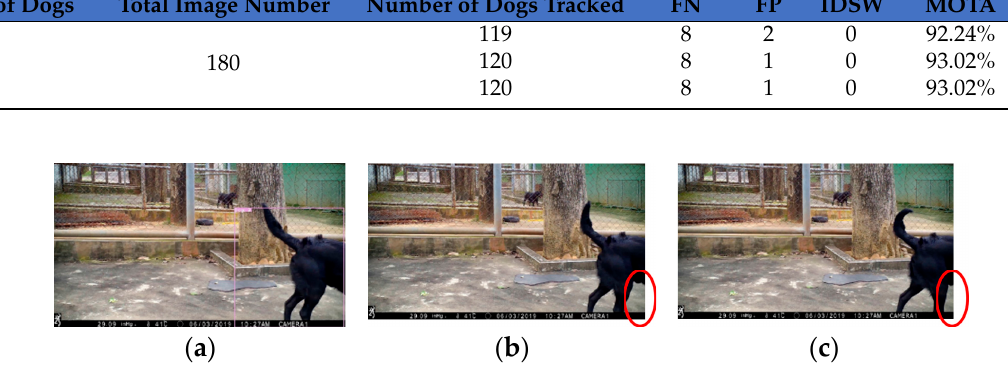
Figure 18. Dogs not tracked in images 164 and 165. ( a ) Image 163; ( b ) Image 164; ( c ) Image 165. The IMG_0014 data-set used in the dog-tracking experiment contained sub-images of four different dogs (ID 1–4). The experimental results for the data-set are presented in Table 14. In the experiments involving ID 1, each of the three models achieved a MOTA value of 98.32%; the tracked regions were all correct. In those involving ID 2, Models 2 and 3 achieved a MOTA value of 69.26%, which was higher than that achieved using Model 1,